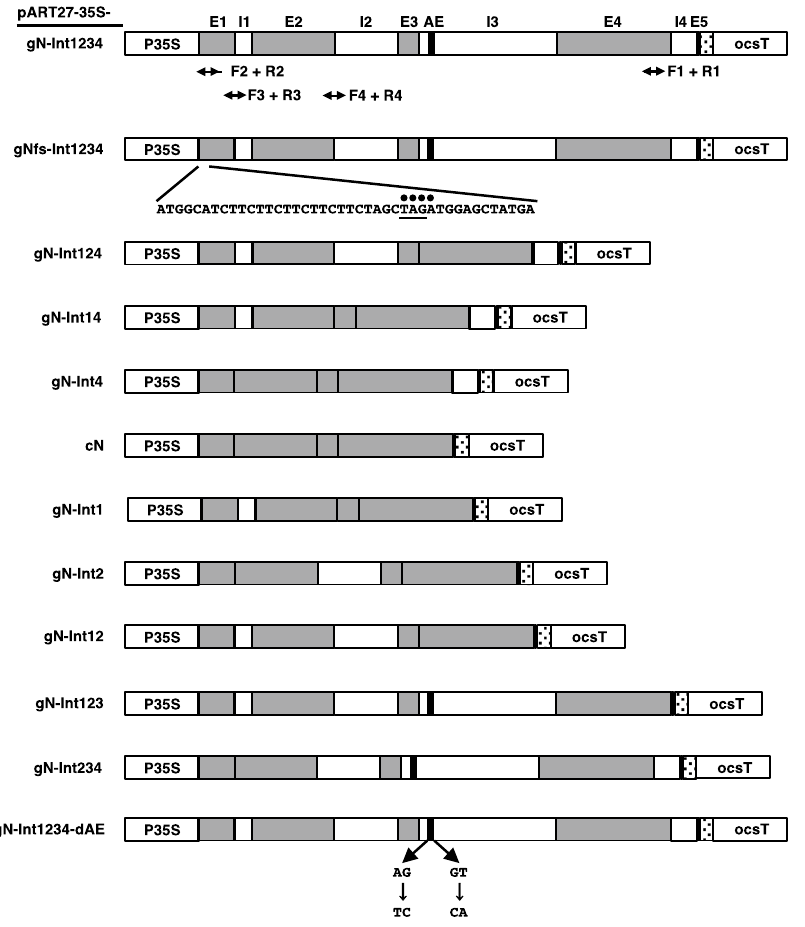
Figure 1. Schematic diagrams of cassettes for transient expression of N with a different combination of introns. The pART27-35S-based binary plasmids used in this study carry an expression cassette containing the CaMV 35S promoter (P35S) and the octopine synthase terminator (ocsT), shown in left- and right-most white boxes, respectively. The five exons (E1–E5) and four introns (I1–I4) of the N gene are shown in gray and white boxes, respectively. E1 includes a coding sequence following a 5 ′ -UTR sequence derived from the vector plasmid. E5 contains a coding sequence linked to a double hemagglutinin tag-encoding sequence shown by a dotted box, followed by a 3 ′ -UTR sequence derived from the vector plasmid. A black bar within I3 indicates the alternative exon (AE) of the N gene. Four dots and a single underline in pART27-35S-gNfs-Int1234 indicate a four-nucleotide insertion at an XbaI recognition site and a stop codon caused by the insertion, respectively. Nucleotide substitutions of the splicing motif for alternative splicing (AG–TC and GT–CA) are indicated in pART27-35S-gN-Int1234-dAE. Bi-directional arrows below pART27-35S-gN-Int1234 indicate the regions amplified by the indicated primer sets (F1 + R1, F2 + R2, F3 + R3, and F4 +